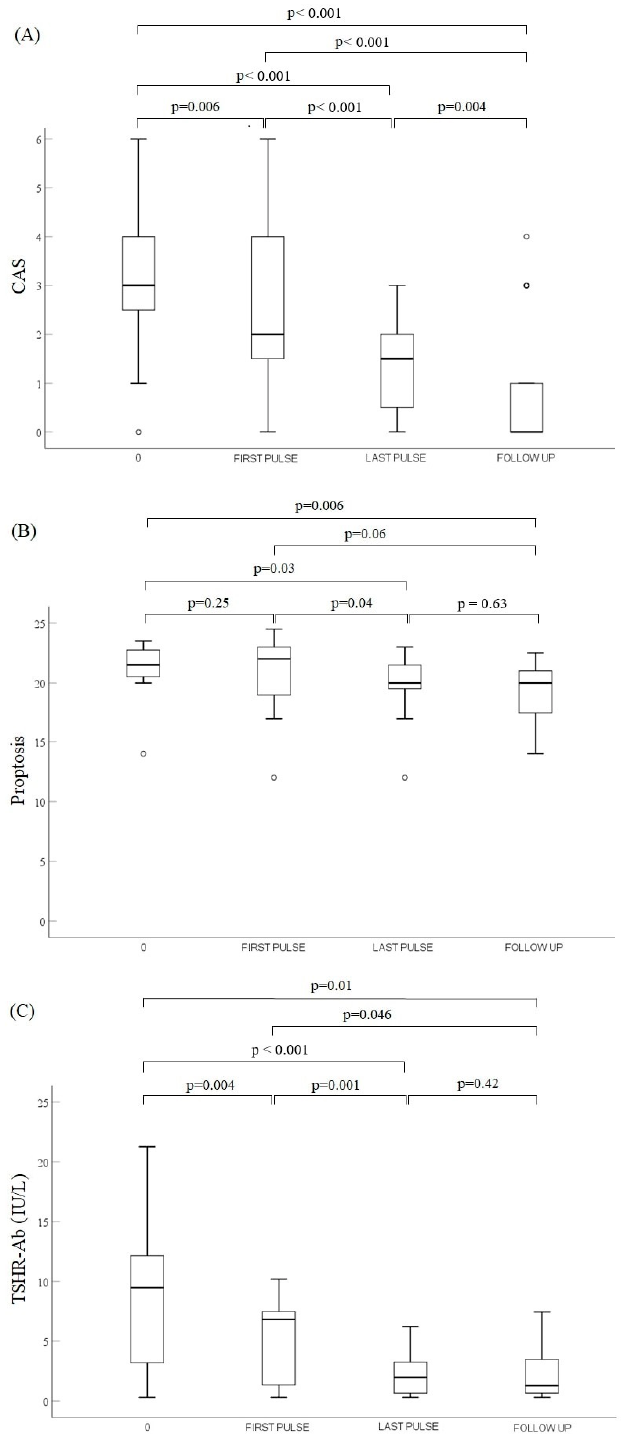
Figure 2. Comparison of variables during the treatment at three time points: 0, FIRST PULSE and LAST PULSE ( n = 26) and after the treatment at FOLLOW UP ( n = 22): ( A ) CAS, ( B ) proptosis and ( C ) TSHR-Ab. Vertical line ranges from maximum to minimum value. Data are shown as median values (line across the box) with interquartile (25th–75th percentile) range (the box). Bullets represent the outliers. Abbreviations: CAS, clinical activity score; TSHR-Ab, thyrotropin receptor antibodies; 0, diagnosis of dysthyroid optic neuropathy; FIRST PULSE and LAST PULSE, before and after the additional treatment with intravenous methylprednisolone pulses, respectively; FOLLOW UP, post-treatment evaluation after median time of 4.5